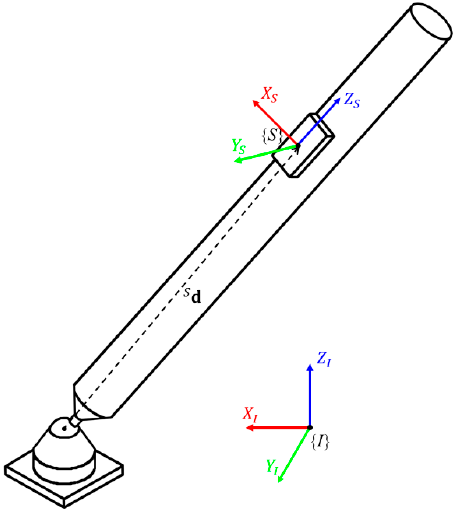
Figure 1. An inertial measurement unit (IMU) attached to a kinematically-constrained link by a ball-and-socket joint.